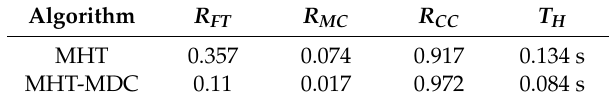
Table 2. The performance metrics of two algorithms in scenario 1.